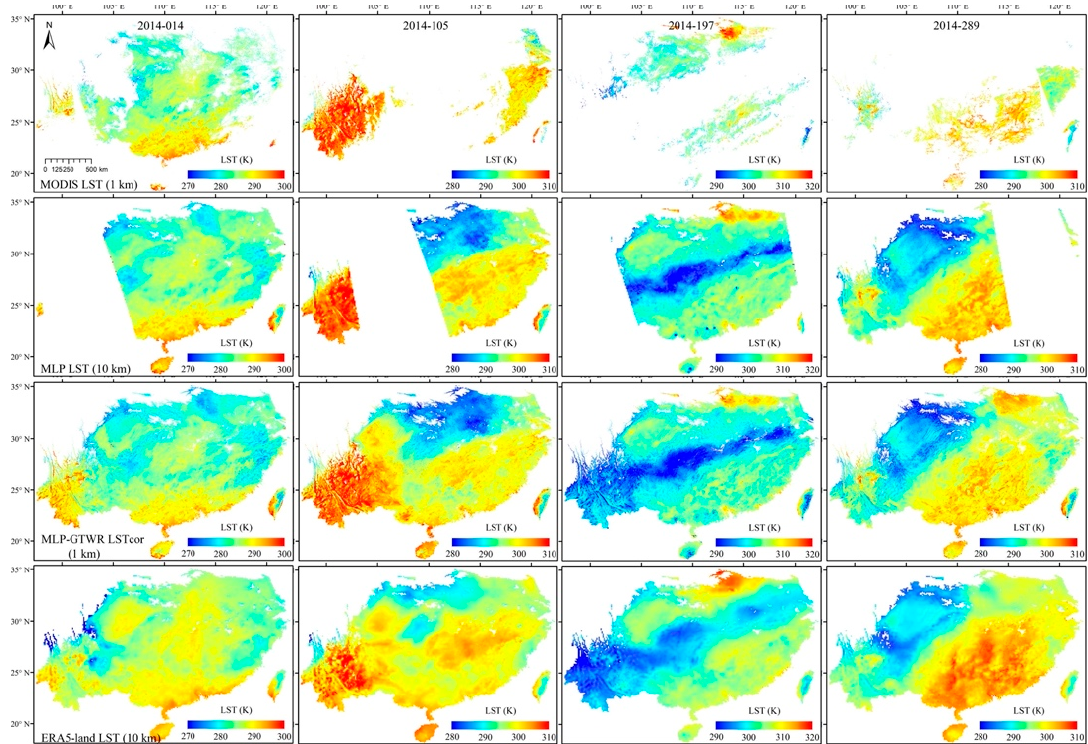
Figure 6. Spatial patterns of daytime 1-km MODIS LST (the first row), 10-km MLP LST (the second row), 1-km MLP-GTWR LST cor (the third row), and 10-km ERA5-Land LST (the fourth row) on the 14th (the first column), 105th (the second column), 197th (the third column), and 289th (the fourth column) days in 2014. The blank areas indicate the missing MODIS LST due primarily to cloud contamination and the AMSR2 gaps due to its orbit swath.